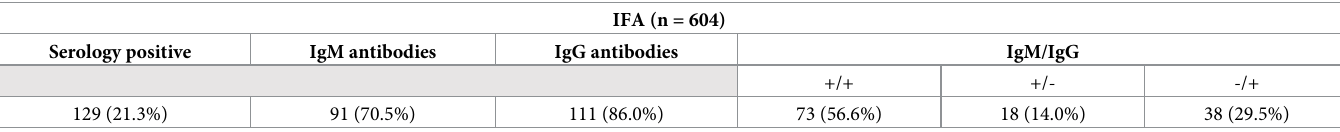
Table 1. Detection of anti- C . burnetii IgM and IgG